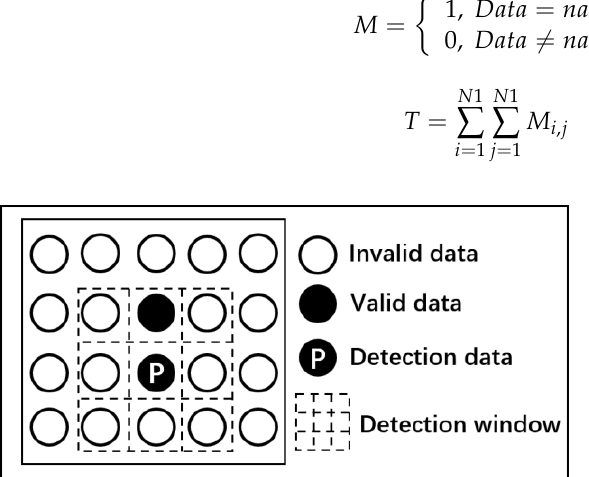
Figure 1. Schematic of the isolated points